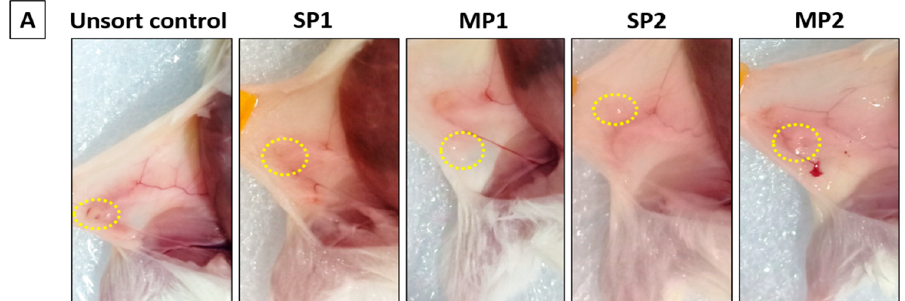
Figure 2. Screening for dye effluxing fractions in breast cancer. ( A ) Hoechst dye efflux activity was displayed by cancer cells across all four major breast cancer subtypes. Hoechst low side population (SP cells gated in P3) and Hoechst high brighter cells retaining the dye were the non-side population cells. The identity of the SP fraction was confirmed via treatment with the drug transporter protein inhibitors verapamil (Vera) and fumitremorgin C (FMC). ( B ) Predominantly, the MCF7 cells dis- played a higher percentage of Hoechst low cells as two separate fractions differing in their DNA con- tent (dual side population fractions SP1 (gated in P3) and SP2 (gated in P4)) within the hummingbird pattern and were chosen for additional experiments. Corresponding Hoechst high dye-retaining non- side population cells (MP1 gated in P6 and MP2 gated in P5) were also selected for